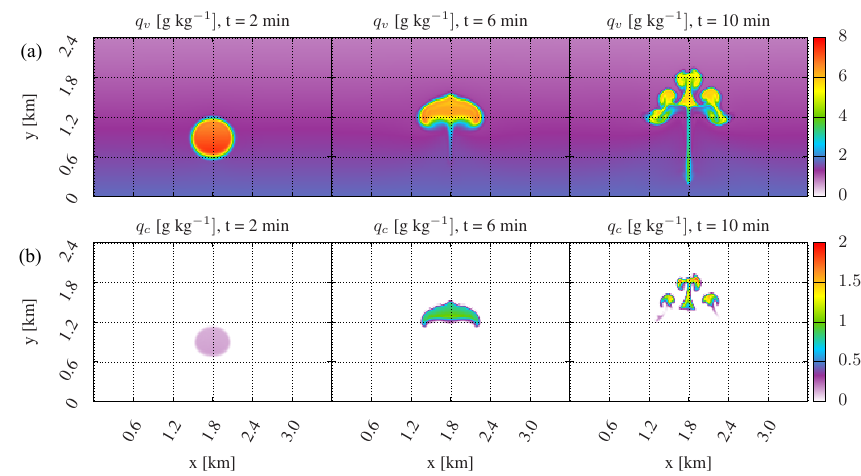
Figure 5. Distribution of (a) the water vapor and (b) the cloud water mixing ratios at 2, 6 and 10min for the Twomey super-droplet scheme in the rising thermal simulation.